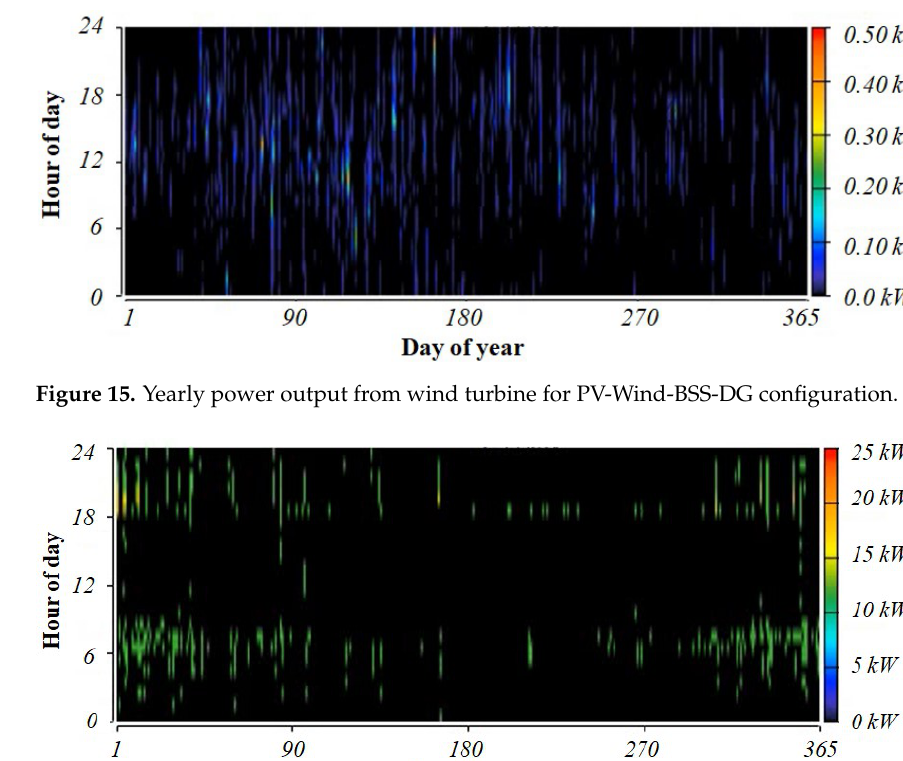
Figure 14. Yearly power output from PV array for PV-Wind-BSS-DG configuration.